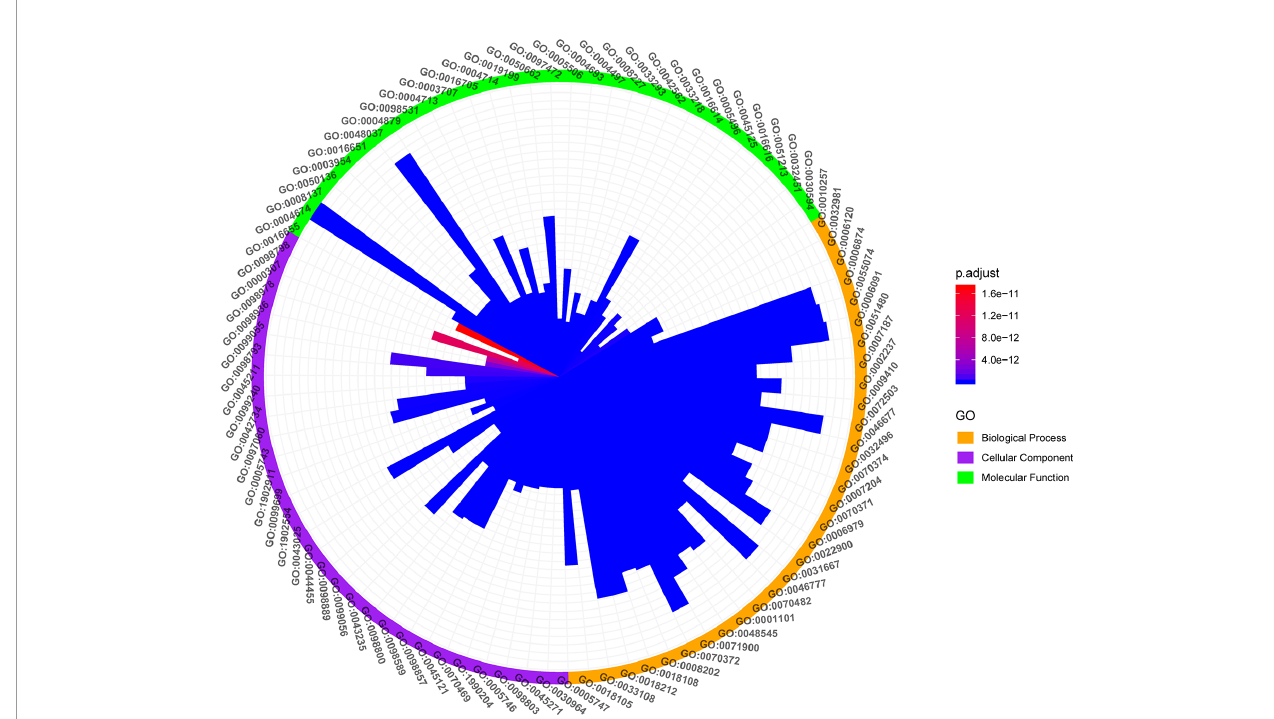
FIGURE 9 | GO enrichment analysis of KGEC Targets. The Orange, purple and bright green color on the circle represent biological processes, cellular component and molecular function, respectively. The color change of the bar represents the signi fi cant degree of the enriched genes in the GO